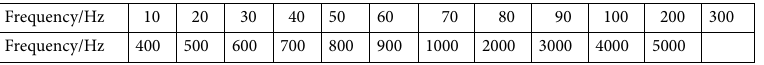
Table 5. The testing frequencies used in the EIS analysis.